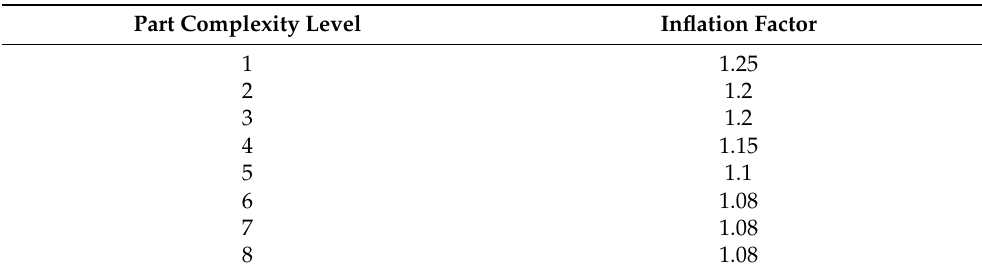
Table 8. Inflation factors applied to machining and finishing operation estimated times for the different part complexity